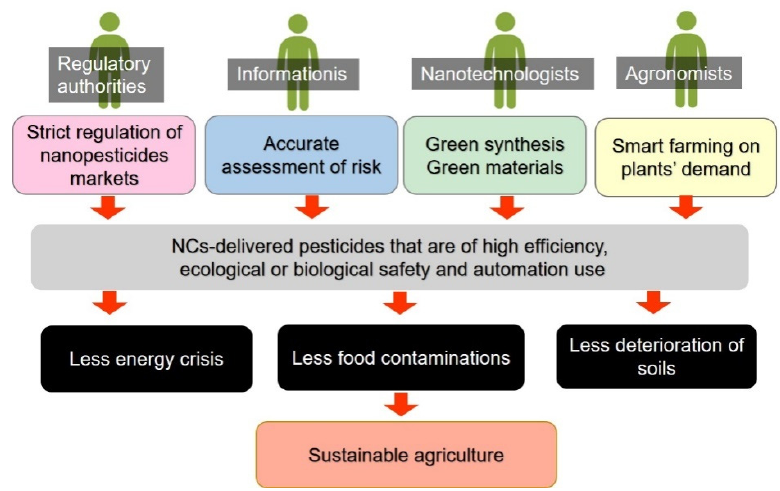
Figure 4. A possible future work of NCs-based pesticides and the potential future of agriculture.